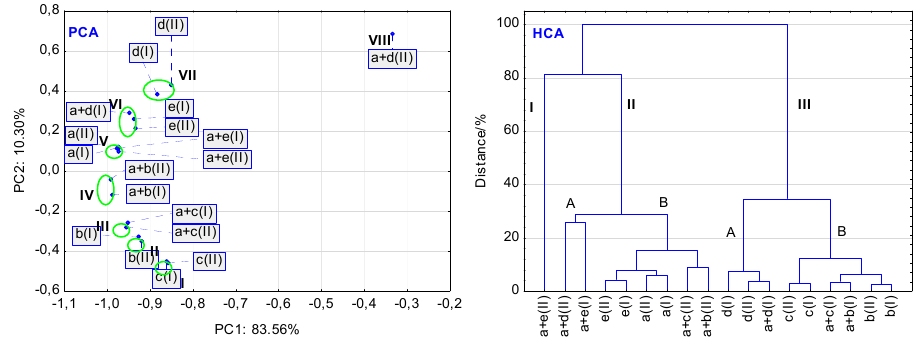
Figure 12. Findings of multivariate calculations using NIR data: PCA score scatter plot, and HCA tree diagram. Linagliptin = a(I) and a(II), lactose = b(I) and b(II), mannitol = c(I) and c(II), magnesium stearate = d(I) and d(II), and polyvinylpyrrolidone = e(I) and e(II). Physical mixtures of linagliptin with lactose = a + b(I) and a + b(II), mannitol = a + c(I) and a + c(II), magnesium stearate = a + d(I) and a + d(II), and polyvinylpyrrolidone = a + e(I) and a + e(II). (I and II) denote the non-stressed and stressed samples, respectively.